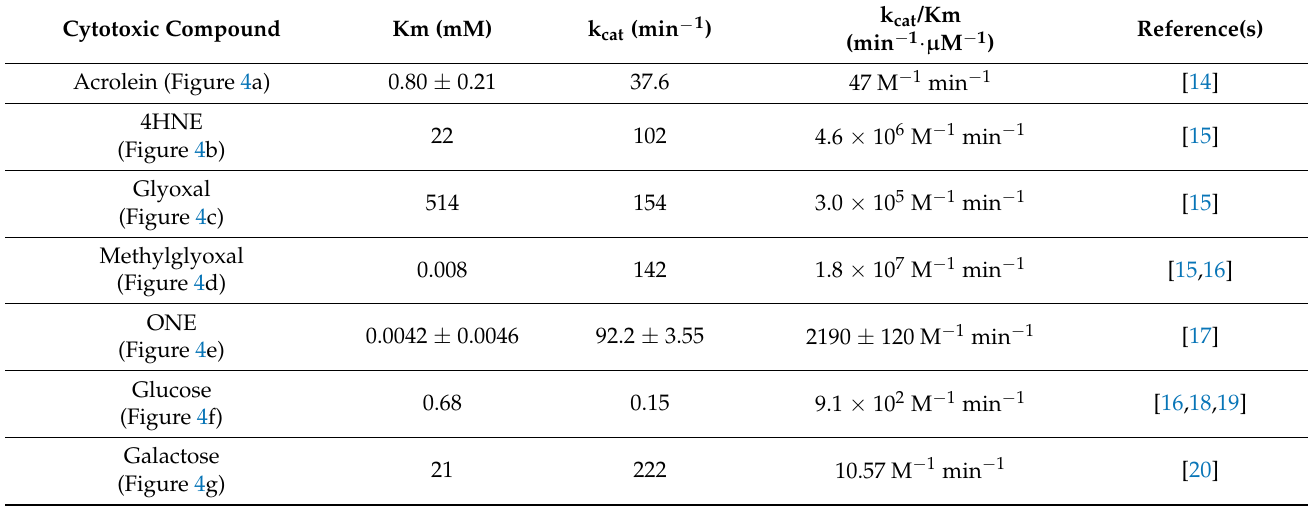
Table 1. Aldose reductase (AR) enzyme kinetics. The values for glucose, galactose, and various cytotoxic compounds specific to the AR are